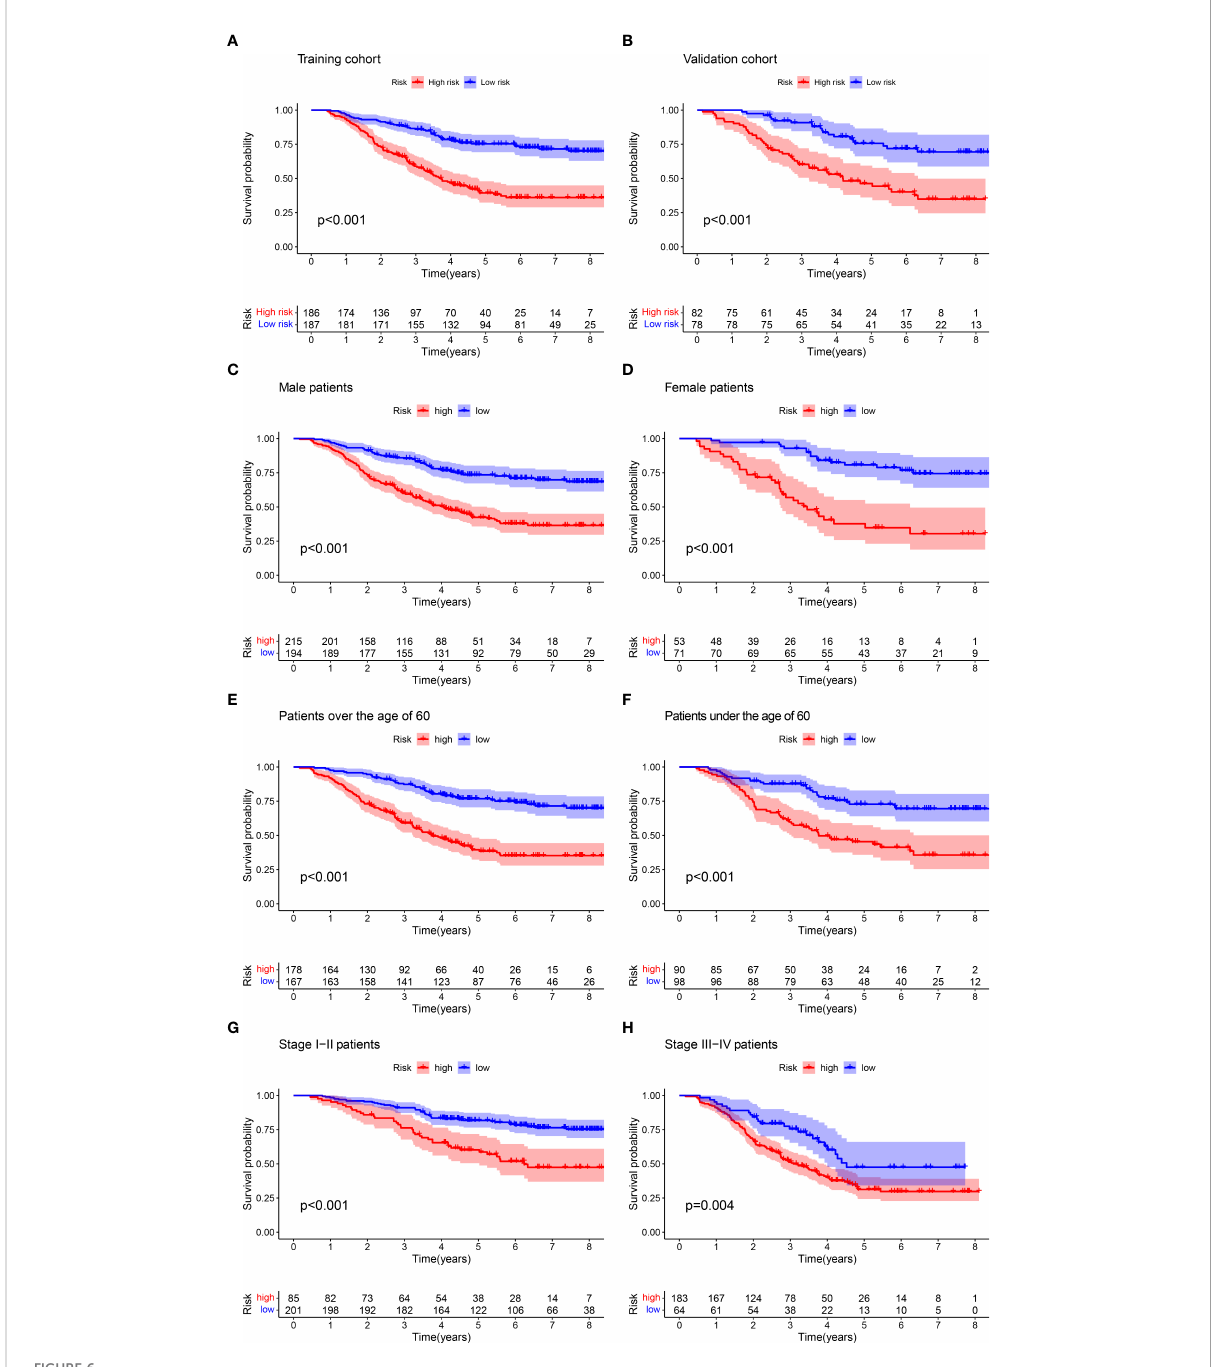
FIGURE 6 Kaplan – Meier curves for the OS of patients in the high- and low-risk groups. There were signi fi cant differences in the survival of high- and low- risk patients in the training group (A) and the validation group (B) , the male group (C) and the female group (D) , the older group (E) and the younger group (F) , and the early group (G) and the advanced group (H)